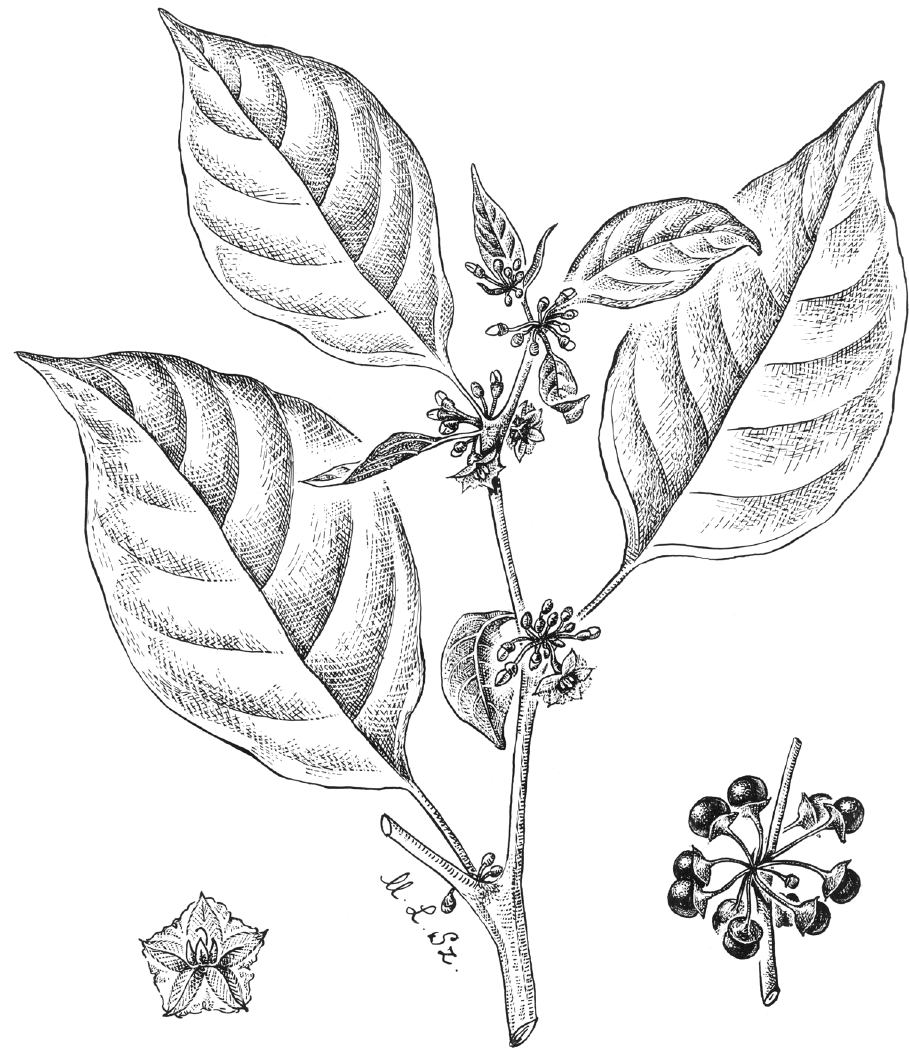
Figure 13. Lycianthes bitteriana (Symon) A.R.Bean. Drawing by M.L. Szent-Ivany, first published in Symon (1985: fig. 5, as S. bitterianum Symon). Courtesy of the Board of the Botanic Gardens and State Herbarium (Adelaide, South Australia), reproduced with